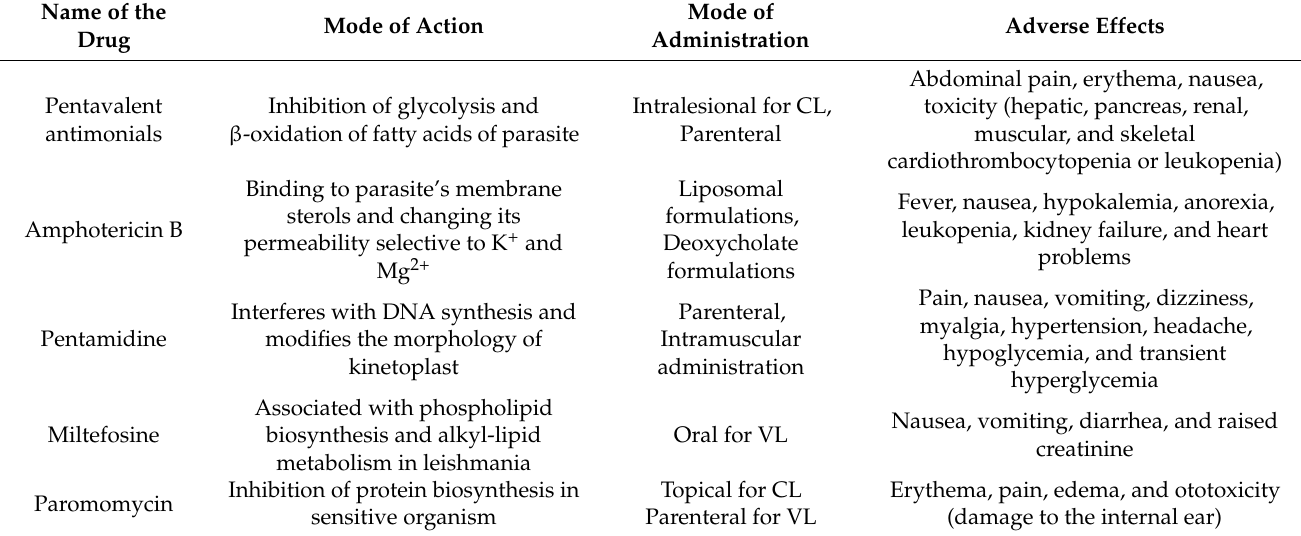
Table 1. Drugs used for the treatment of